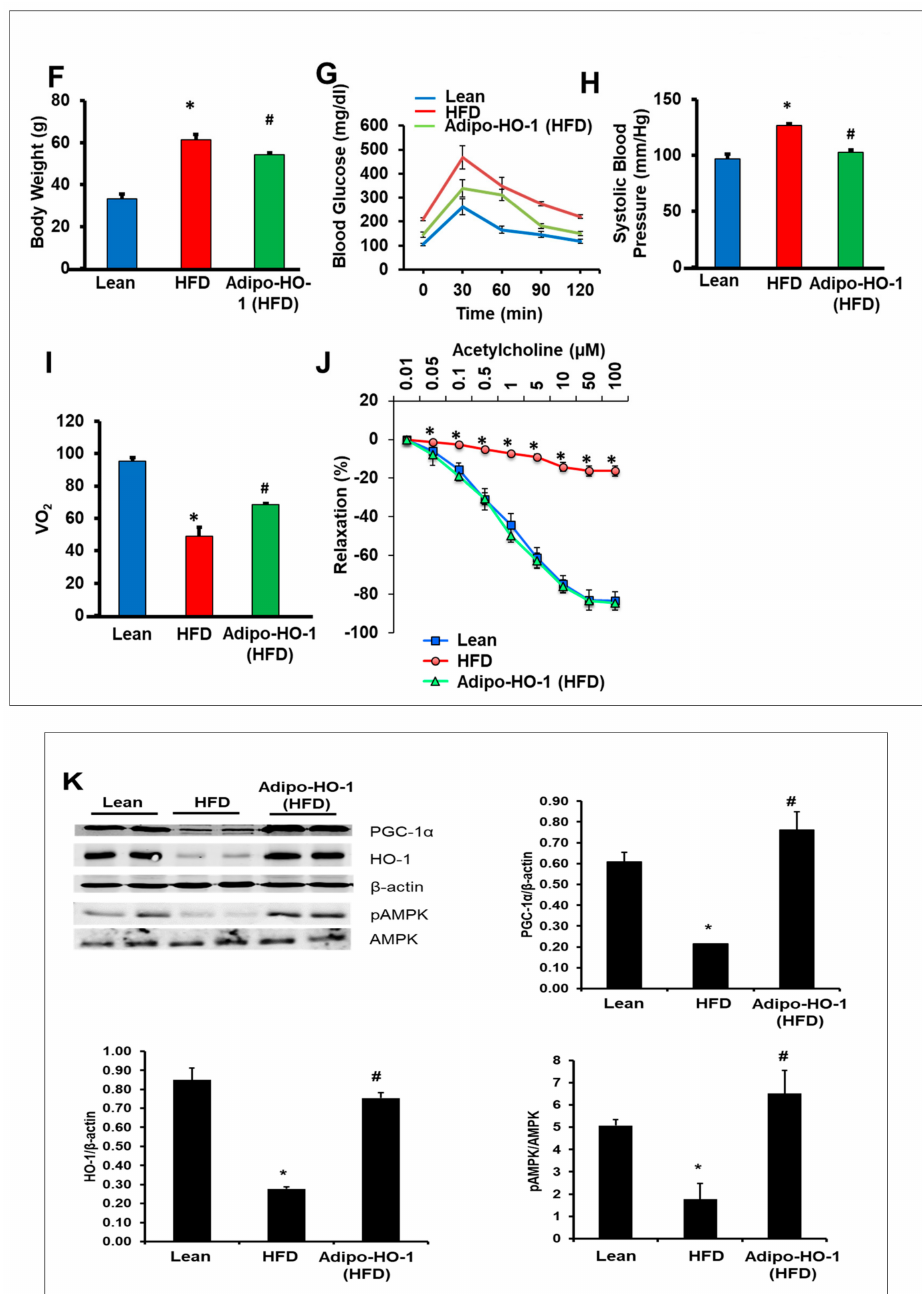
Figure 1. E ff ects of adipocyte-specific overexpression of HO-1 (heme oxygenase-1) in high-fat diet (HFD)-fed mice. ( A ) HO-1 mRNA expression levels in visceral fat * p < 0.05 vs. control, kidney and heart in Lnv-adipo-HO-1, n = 5. Comparisons of adipose tissues of lean, HFD-fed, and Lnv-adipo-HO-1 (HFD)-fed mice: ( B ) histological analysis of adipocyte diameter, using hematoxylin-eosin and Masson-trichrome staining; ( C ) immunofluorescence photomicrographs of PGC-1 α expression (red staining), scale bar 20 µ m (10 × ). ( D ) Immunomorphometrical measurement of nuclear localization of PGC-1 (AU); ( E ) mRNA levels of HO-1 and PGC-1 α . ( F ) Body weight (BW); ( G ) fasting glucose (at 10) and glucose tolerance test; ( H ) Systolic blood pressure; ( I ) oxygen consumption (VO2); ( J ) acetylcholine-mediated relaxation of renal interlobar arteries n = 5, * p < 0.05 vs. lean, # p < 0.05 versus fat. ( K ) Representative Western blot analysis of PGC-1 α , HO-1, pAMPK, and AMPK in heart-tissue lysates of lean, HFD-fed, and Lnv-adipo-HO-1 HFD-fed mice; n = 5, * p < 0.05 versus lean; # p < 0.05 versus HFD